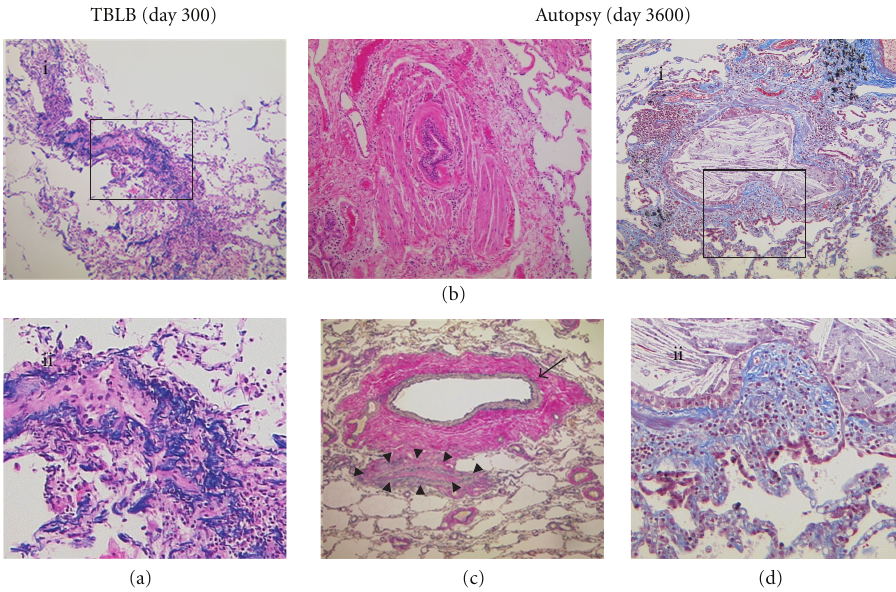
Figure 2: Pathological findings of the TBLB and autopsy. In the TBLB specimens, Victoria blue staining shows the narrowing of bronchioles (a-i) with infiltration of lymphocytes in bronchial walls. There are no fibrotic lesions (a-ii). In the lung tissue at autopsy, there is extensive obliteration or disappearance of bronchioles due to prominent smooth muscle hypertrophy and submucosal collagen deposition (b). Elastica van Gieson staining shows preexisting elastic fibers of the bronchiolar wall with complete fibrous obliteration, which suggests that there was the end-stage obstruction of bronchiole (arrow heads) with fibrotic tissues, surrounded by elastic fibers (black). Residual bronchial arteriole (arrow) is also observed (c). Infiltration of lymphocytes and macrophages into bronchial wall (d-ii) was occasionally observed in residual bronchioles (d-i) by Masson’s Trichrome staining (blue; collagen layer in bronchial